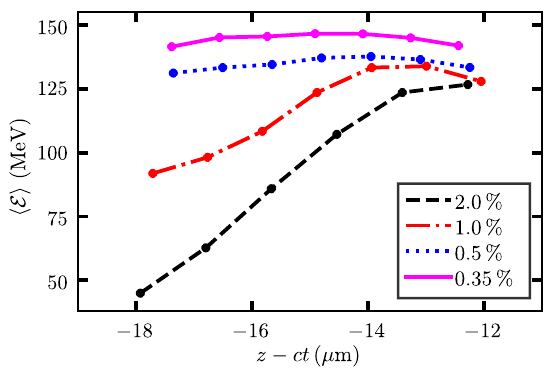
FIG. 6. Same as Fig. 5 at the exit of the gas